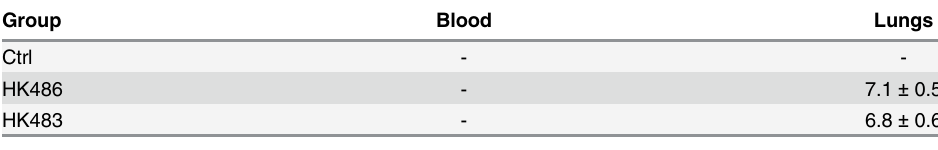
"-": not detectable. n =